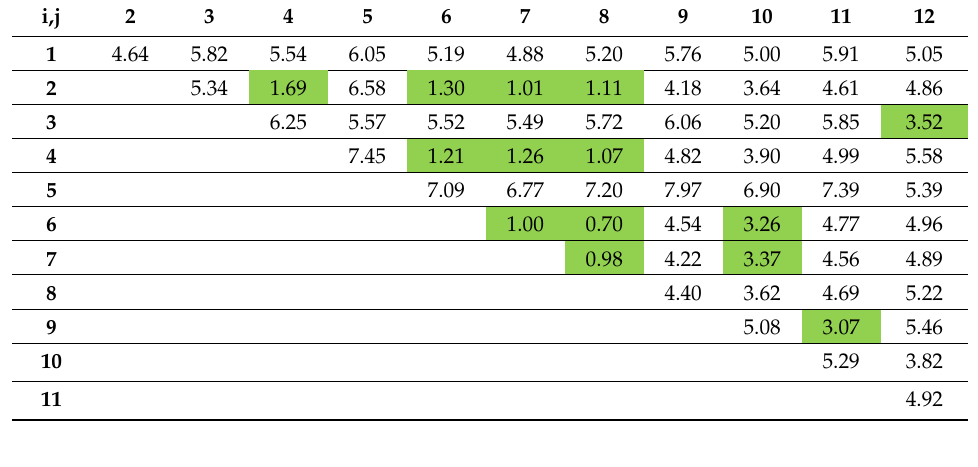
Figure 10. Distances between steering vectors in spoofing scenario 2. Table 5. Distances between steering vectors in spoofing scenario 2.